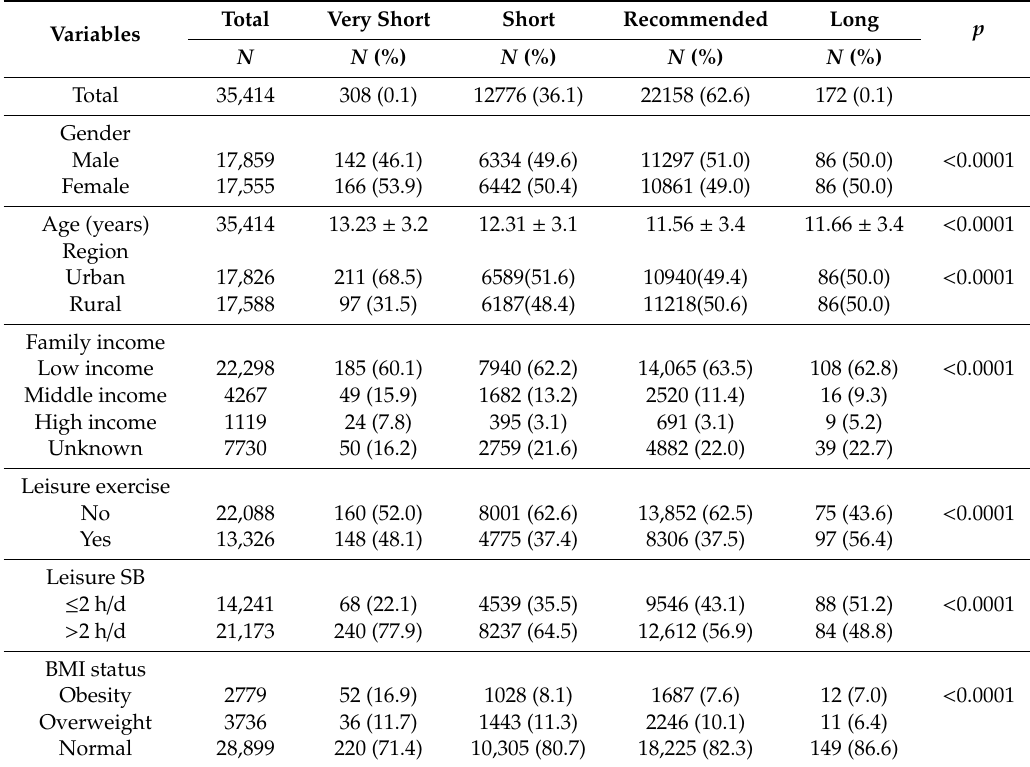
Table 1. Demographic characteristics and physical activity of di ff erent sleep groups.